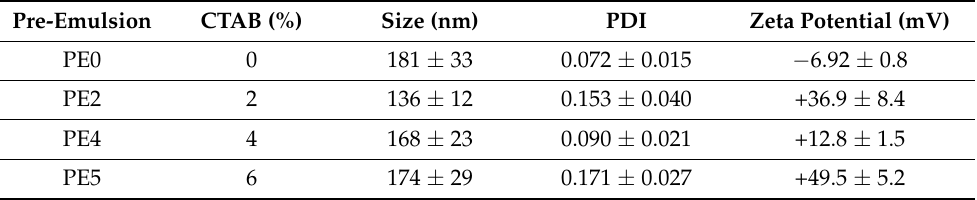
Table 1. Size (nm) and zeta potential (mV) for pre-emulsions prepared with different concentrations of CTAB and vitamin